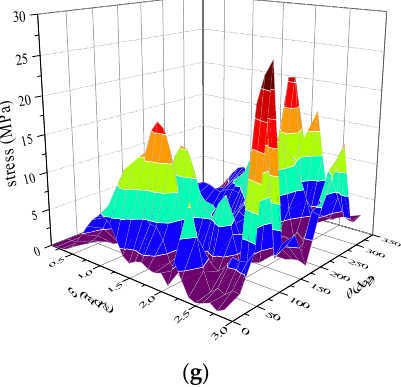
Figure 3. Stress transfer function as follows: ( a ) Hot spot 1, ( b ) hot spot 2, ( c ) hot spot 3, ( d ) hot spot 4, ( e ) hot spot 5, ( f ) hot spot 6, and ( g ) hot spot 7.